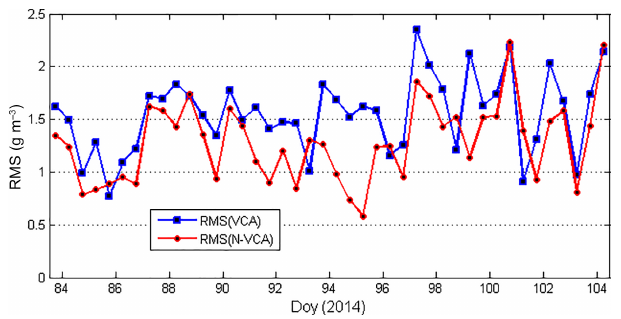
Figure 10. A comparison of RMS for the VCA and N-VCA schemes during the period of 21